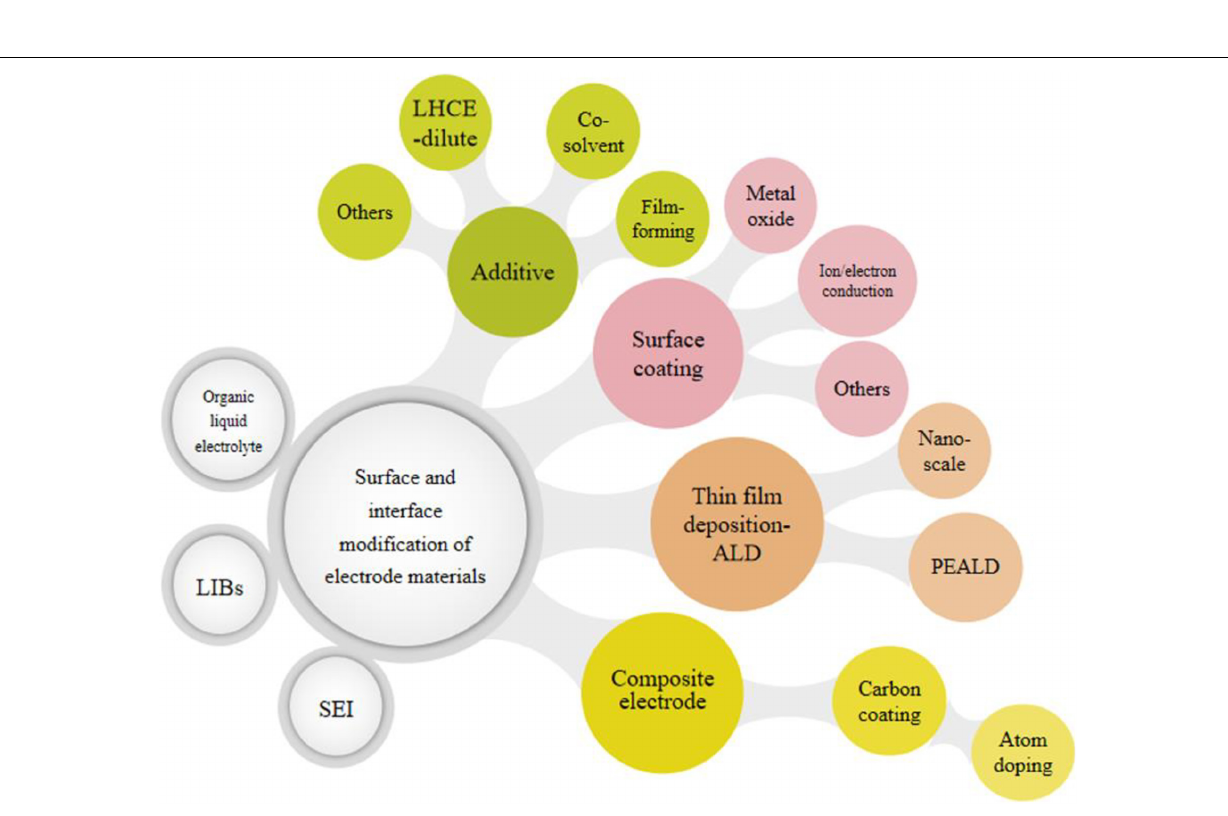
Frontiers in Energy Research |